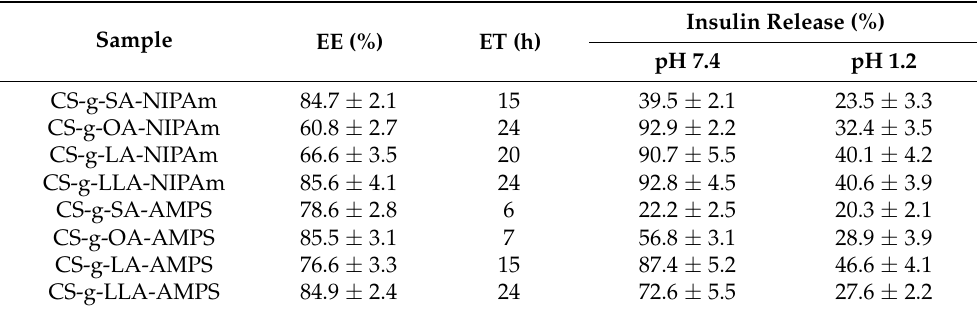
Table 2. Comparison of % encapsulation efficiency (EE), equilibrium time ET (h), and release study of CS-based NIPAm and AMPS matrices at two different pHs for the insulin